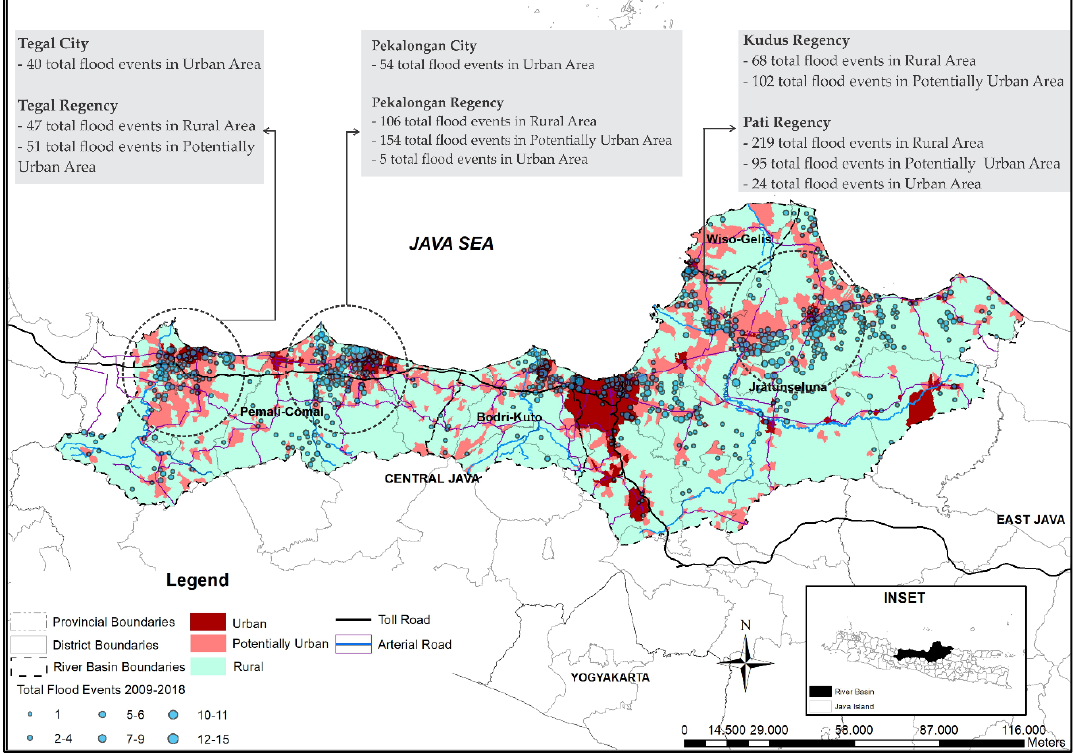
Figure 7. Urbanization and Flood Events in the Four Selected River Basins.